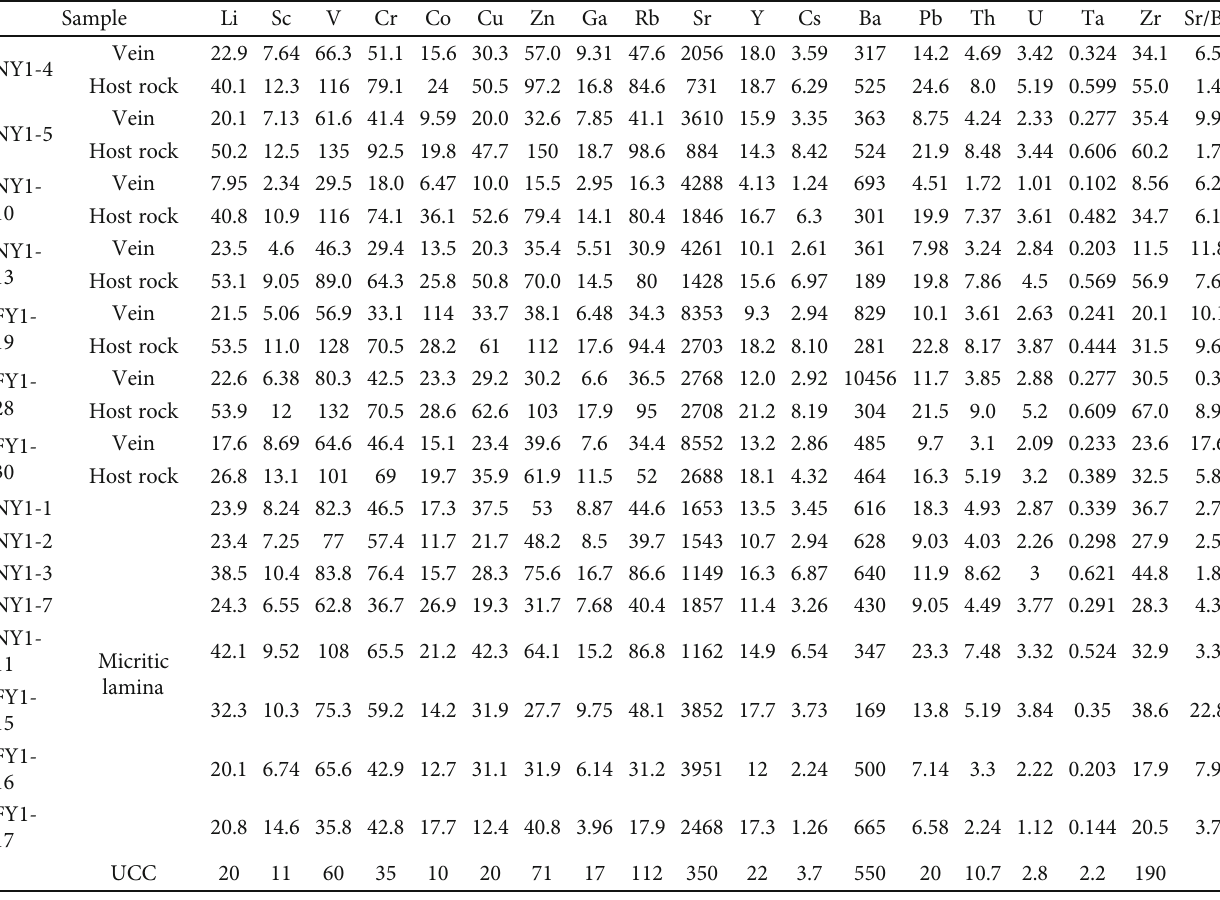
Table 5: The trace elements results of veins, host rocks, and micritic lamina ( μ g/g).